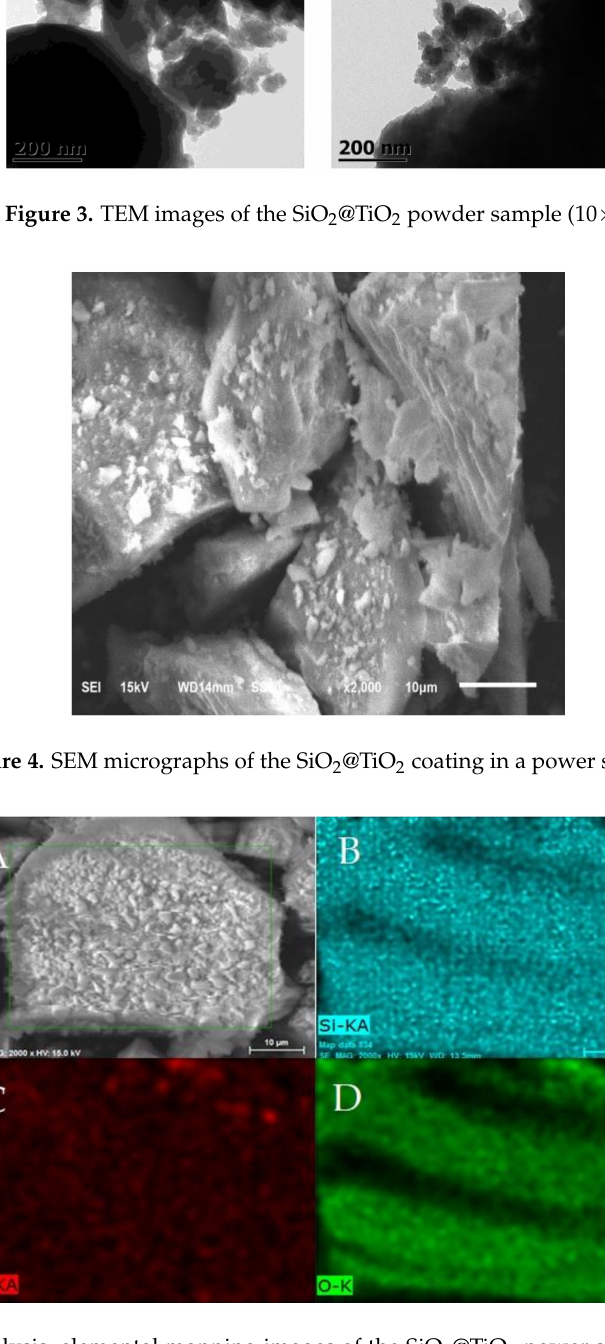
Figure 5. EDS analysis, elemental mapping images of the SiO 2 @TiO 2 power sample: ( A ) EDS area; ( B ) Silicon; ( C ) Titanium and ( D )